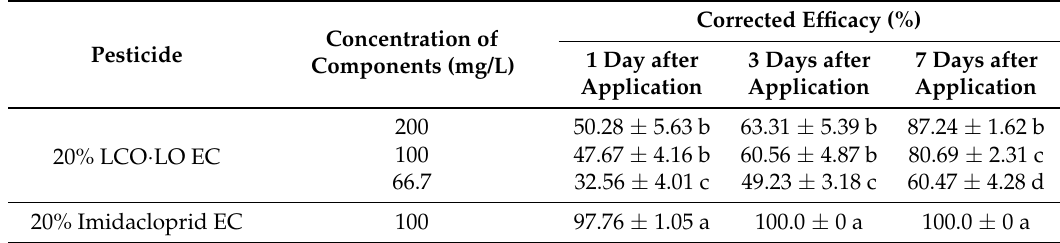
Table 8. The result of field trials of 20% LCO · LO EC on Aphis citricola van der Goot (June 2012, Yangling,